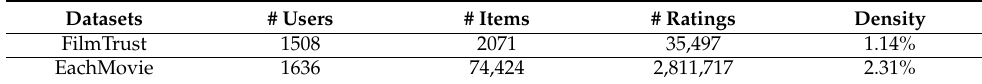
Table 3. Statistics of four datasets (# denotes “Number